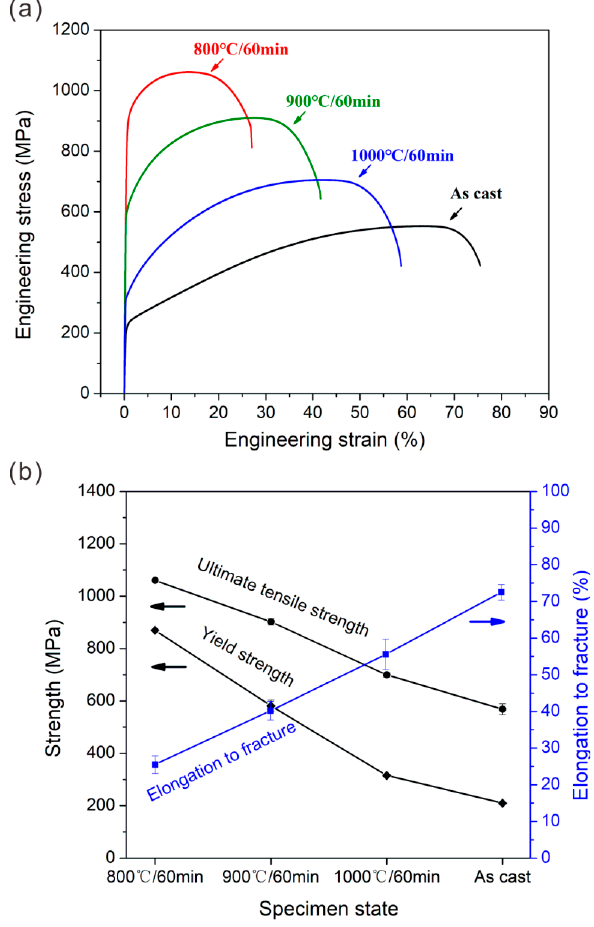
Figure 12. ( a ) Engineering tensile stress-strain curves and ( b ) yield strength, ultimate tensile strength and elongation to fracture in as-cast and different annealed HEA states. and elongation to fracture in as-cast and different annealed HEA